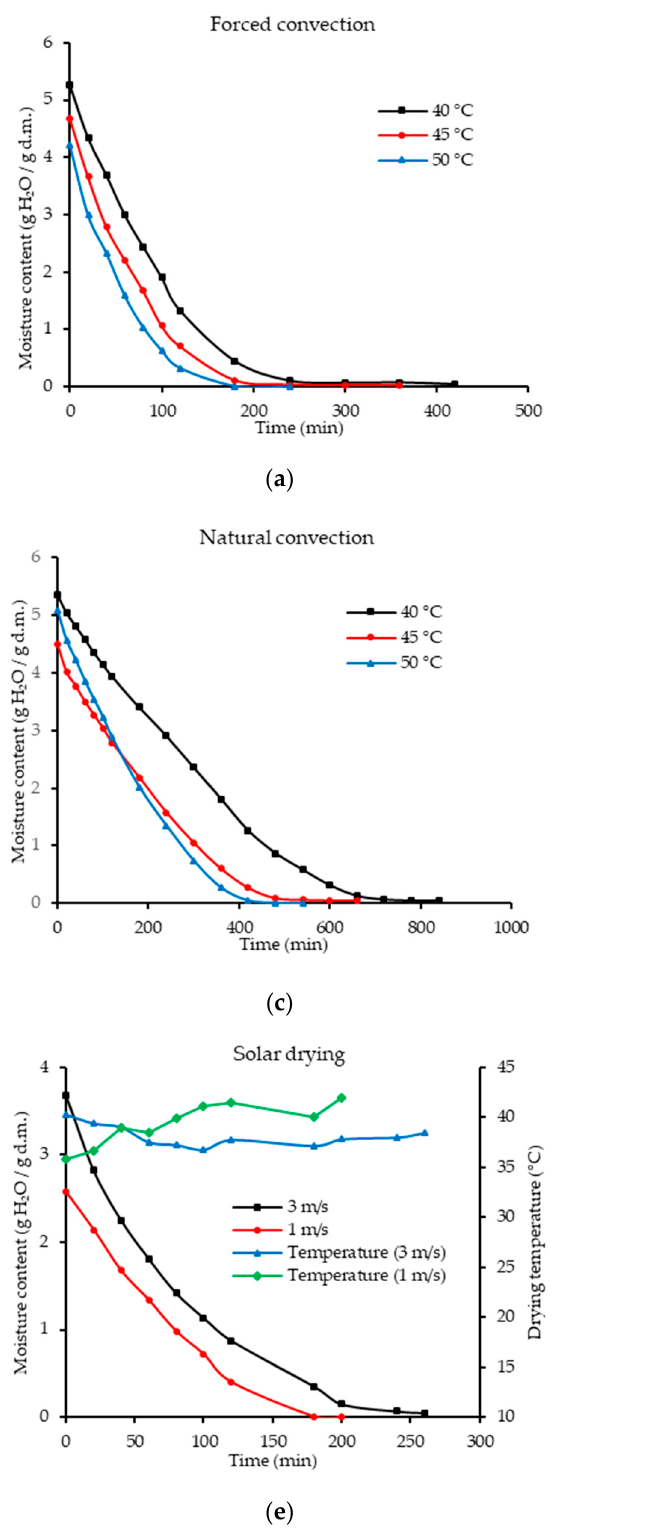
Figure 2. Drying kinetics of ( a ) forced convection and ( c ) natural convection; drying rate ( b ) forced convection, and ( d ) natural convection at di ff erent temperatures; solar drying kinetics ( e ) and drying rate ( f ).